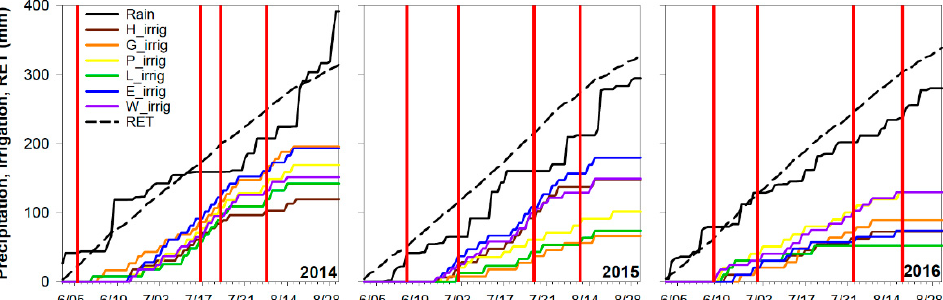
Figure 4. Cumulative precipitation (mm), irrigation (mm), and reference evapotranspiration (mm, ‘RET’) data for 1 June–31 August for 2014–2016 growing seasons on Isherwood Farms. Irrigation time series for fields H, G, P, L, E, W are labelled as H_irrig, G_irrig, P_irrig, L_irrig, E_irrig, and W_irrig, respectively. Airborne missions are demarcated by red vertical lines.